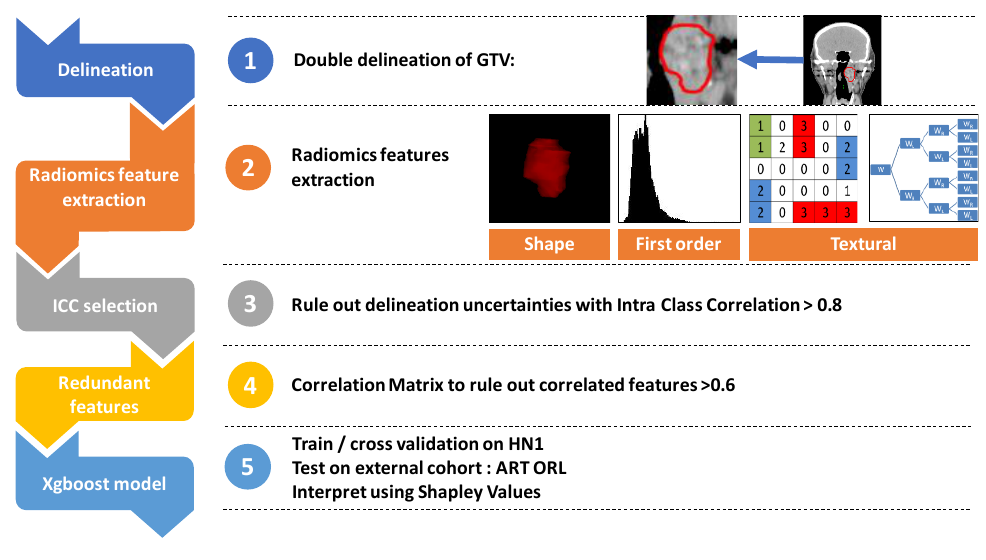
Figure 7. The study workflow.